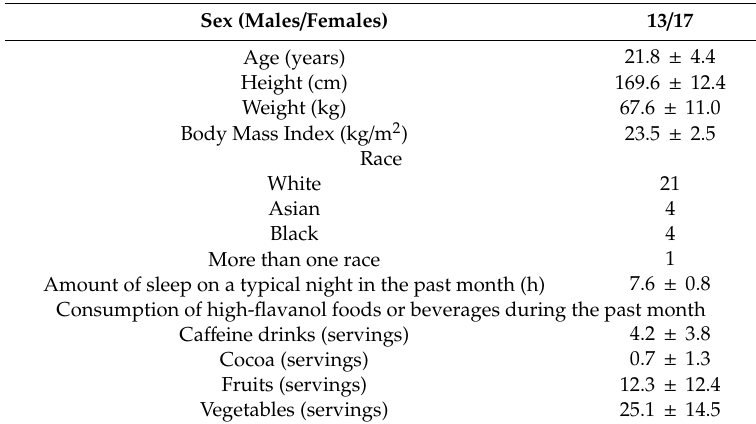
Table 3. Participant